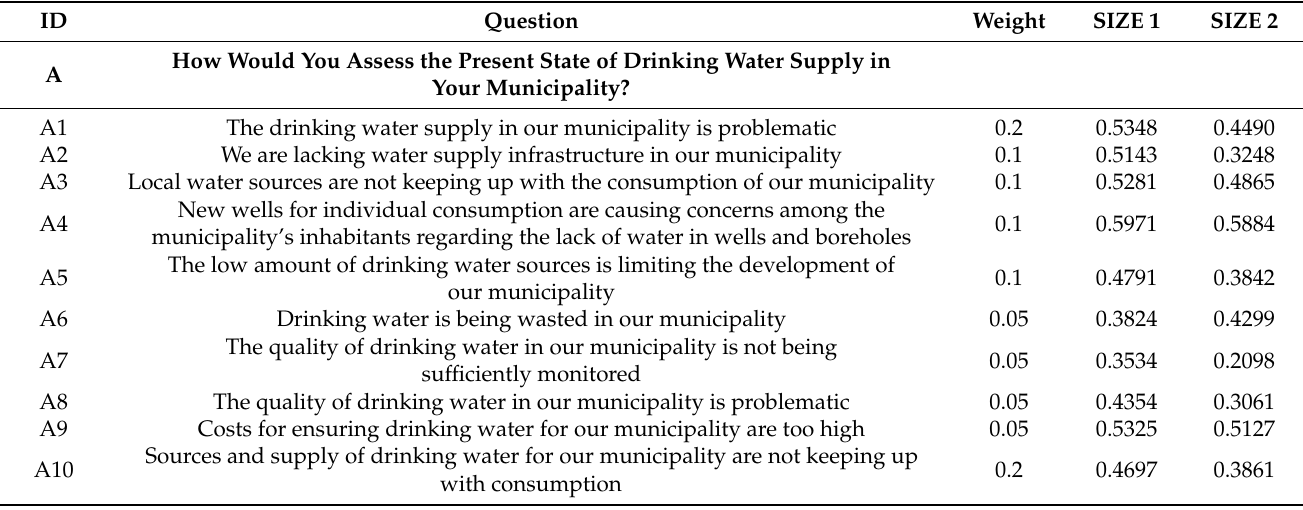
Table 4. Sub-questions of DWSTI: weights and average